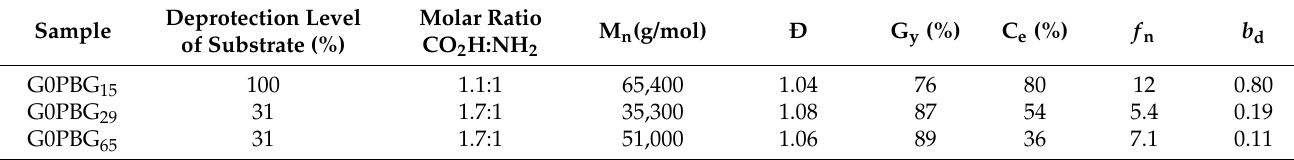
Table 1. Characteristics of arborescent G0PBG with different